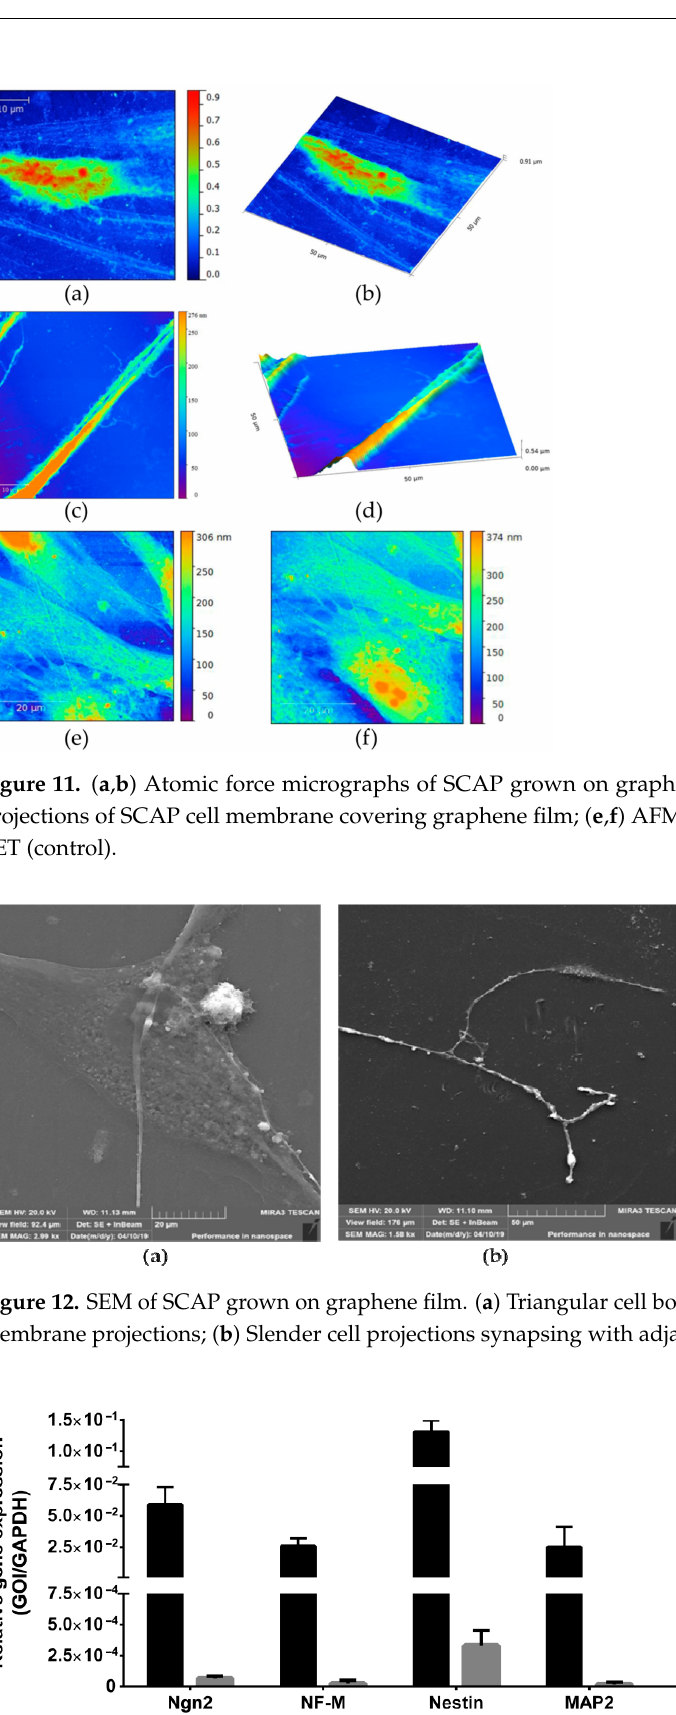
Figure 13. Gene expression analyses of neuronal markers of SCAP grown on graphene film and PET PET (control).